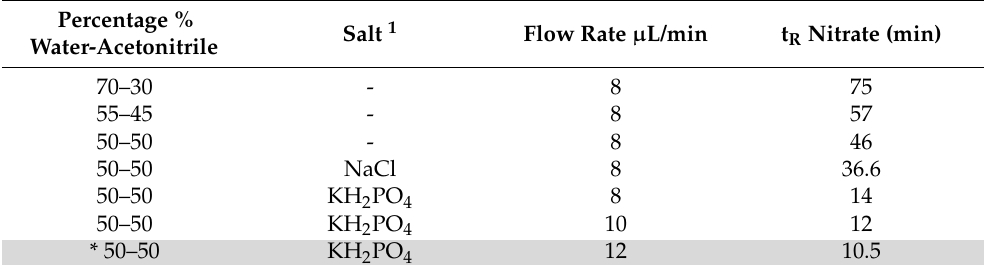
Table 2. Optimization of mobile phase in IE-CapLC. For all mobile phases pH = 3.1; 1 130 mM concentration. * Optimal conditions. For more explanations see text.